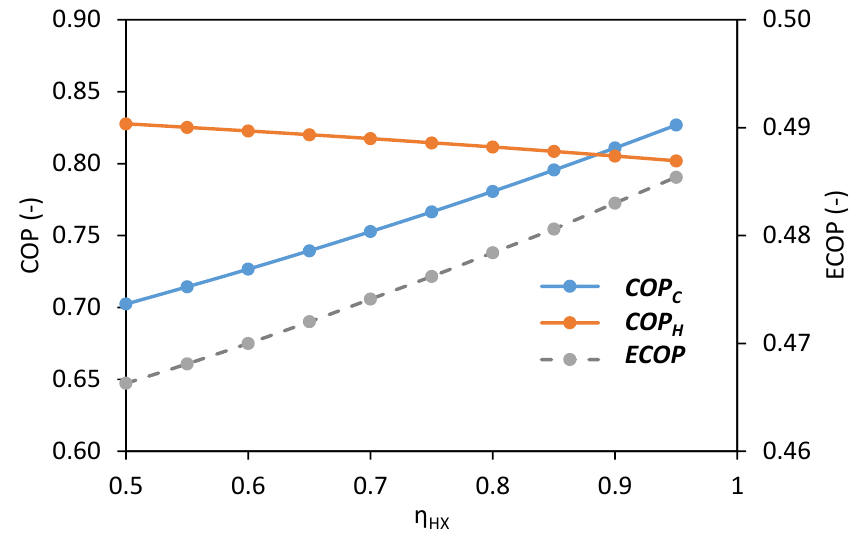
Figure 3. AHP COP C , COP H , and ECOP as function of the SHX effectiveness.